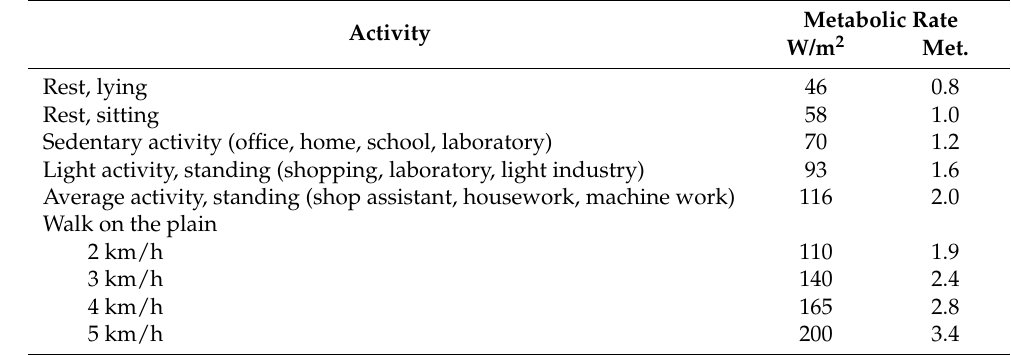
Table 3. Metabolic rate values for different